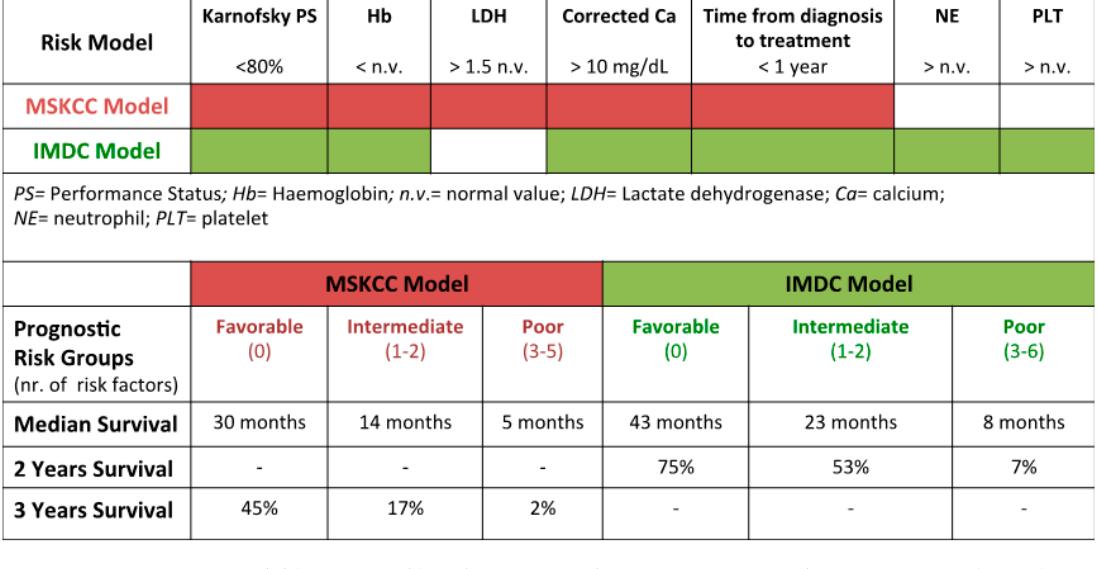
Figure 1. MSKCC Model (Motzer et al.) and International Metastatic RCC Database Consortium (IMDC) Model (Heng et al.): risk categories and relative median survivals in renal cell carcinoma [13,40–42]. The color code represents the presence of a given prognostic factors for each model: PS, Hb, LDH, corrected Ca, time from diagnosis to treatment (red) for MSKCC model; PS, Hb, corrected Ca, time from diagnosis to treatment, NE, PLT (green) for IMDC